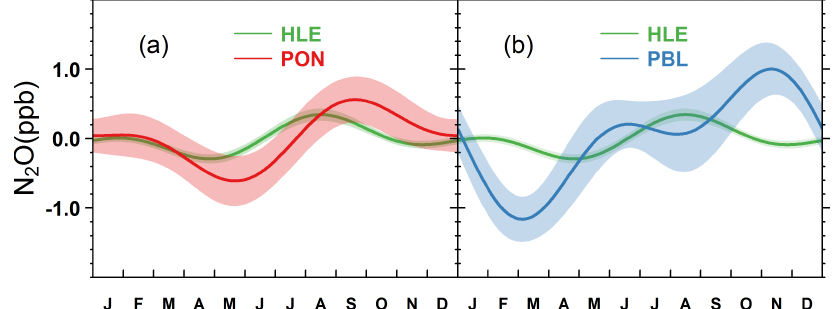
Figure 7. The mean N 2 O seasonal cycles observed at (a) HLE and PON and (b) HLE and PBL. For each station, the mean seasonal cycle is derived from the harmonics of the smoothed fitting curve in Fig. 6. Shaded area indicates the uncertainty of the mean seasonal cycle calculated from 1 SD of 1000 bootstrap